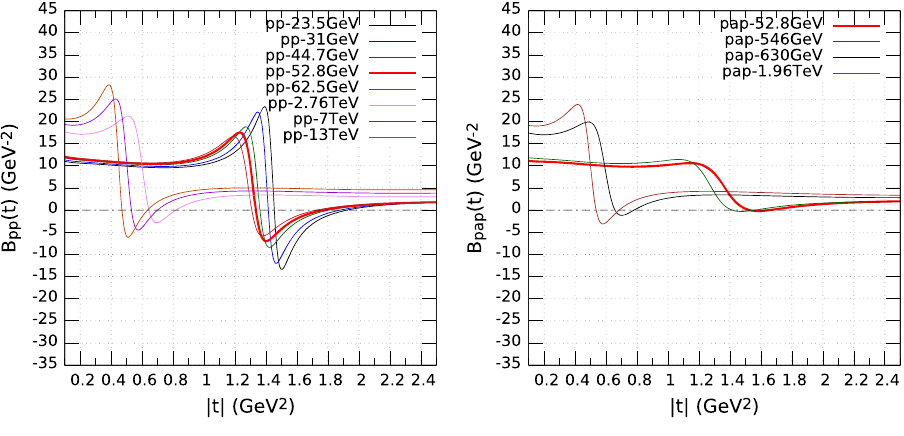
Fig. 13 Slopes B pp ( t ) and B ¯ pp ( t ) at increasing energy (left panel) and the s -dependence of the averaged slopes < B pp ( s ) > , < B ¯ pp ( s ) > together with experimental data (right panel) Fig. 14 Slope B ( s , t ) for pp (left panel) and ¯ pp ) (right panel) at selected